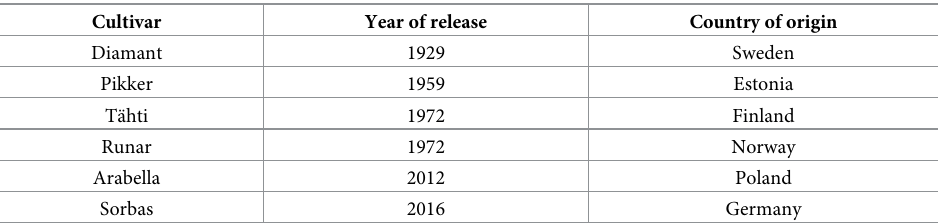
Table 1. Wheat cultivars used in the